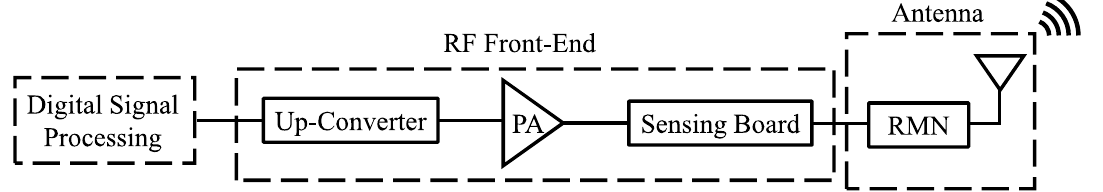
Figure 1. Simplified block scheme of a transmitter.